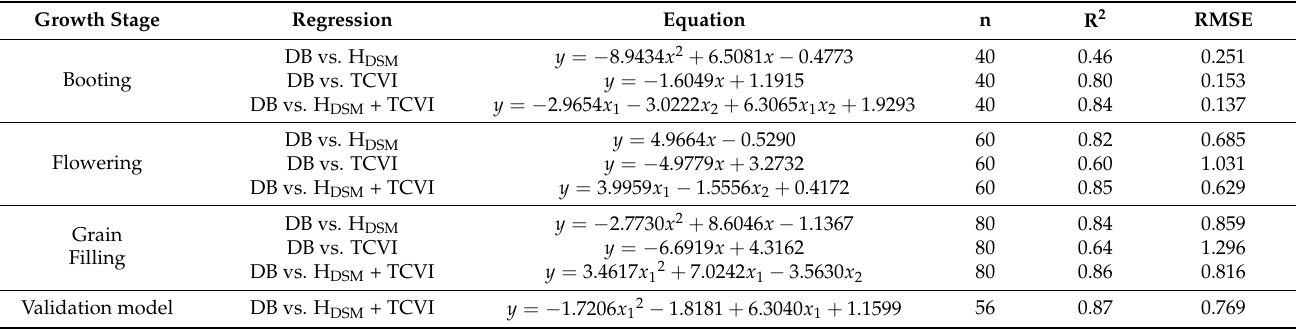
Table 8. Descriptive statistics for overall mean